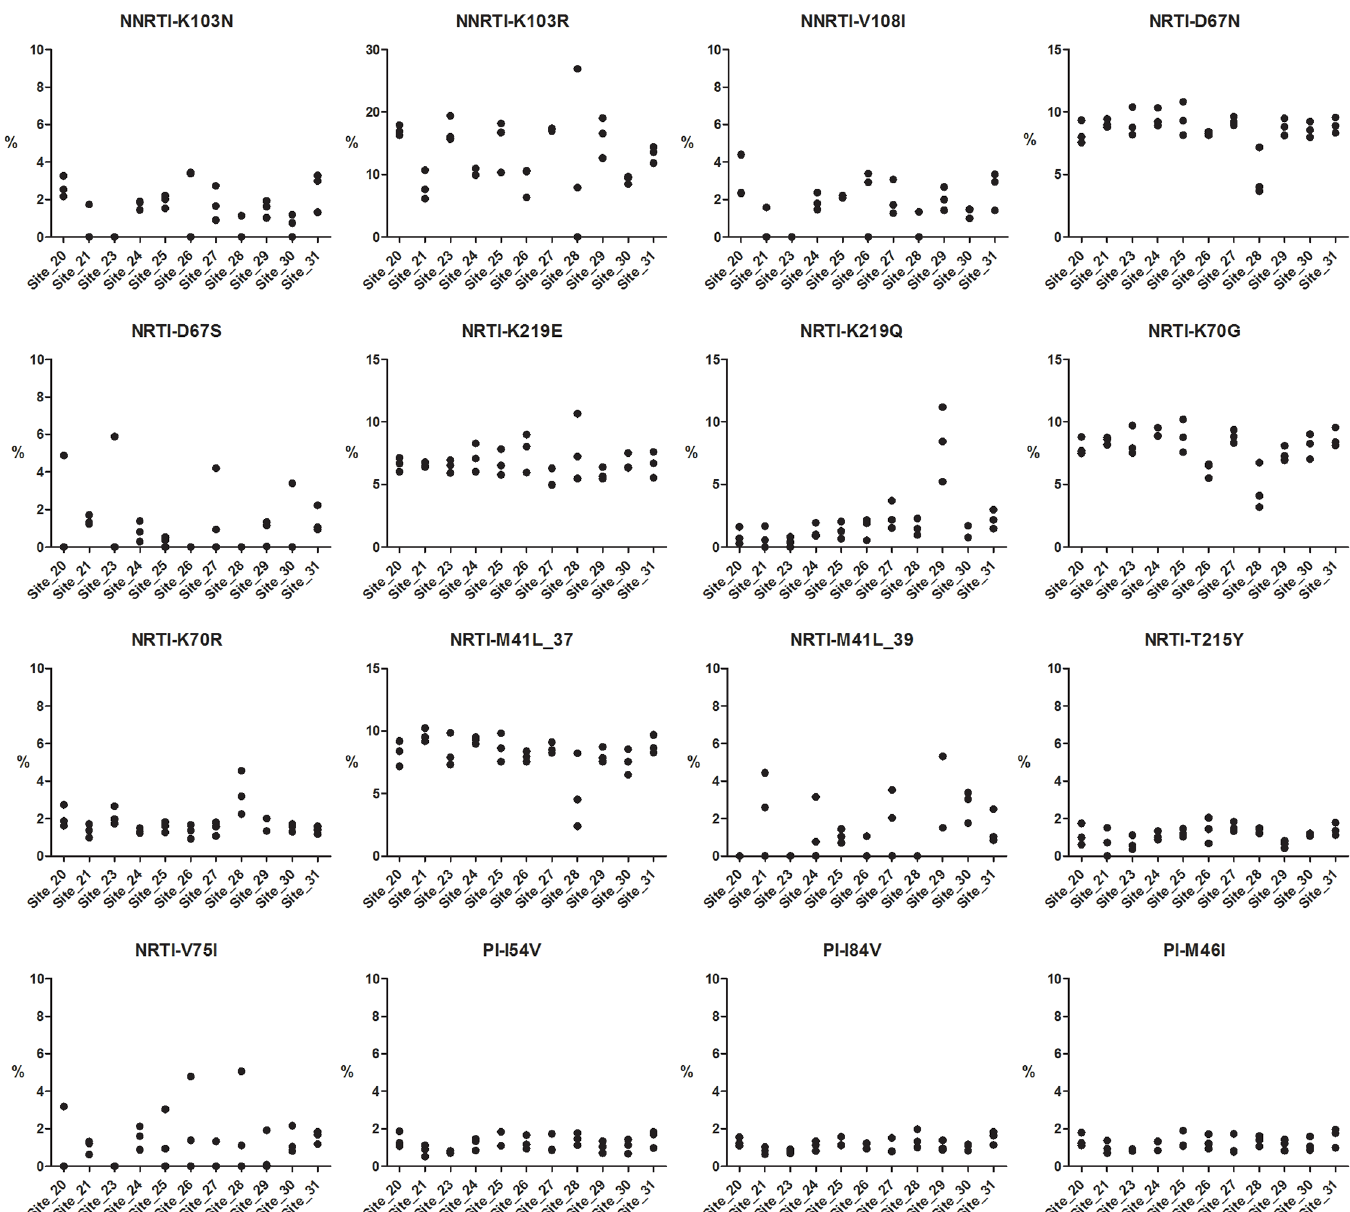
Fig 1. Triplicate sample analysis. A set of three samples was measured in triplicate at each of the 11 sites. Variant percentages measured in the triplicate samples are shown for each